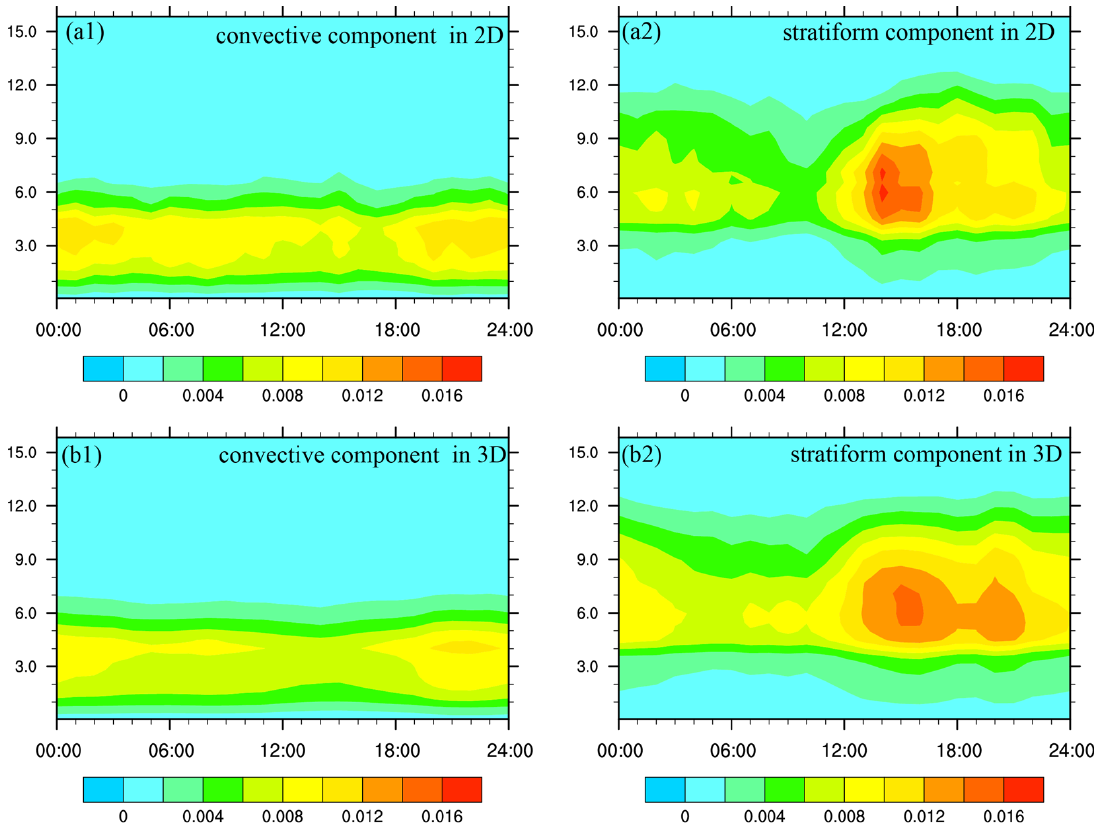
Figure 7. Diurnal composite of IWP+LWP (mm) in ( a1 ) convective regions in the 2D model simula- tions and ( a2 ) stratiform regions in the 2D model simulations, and diurnal composite of IWP+LWP (mm) in ( b1 ) convective regions in the 3D model simulations and ( b2 ) stratiform regions in the 3D model simulations.